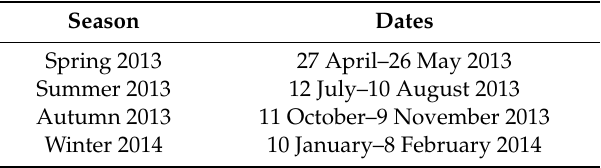
Table 1. Dates of enhanced simulation periods for model evaluations including a simulation spin-up.